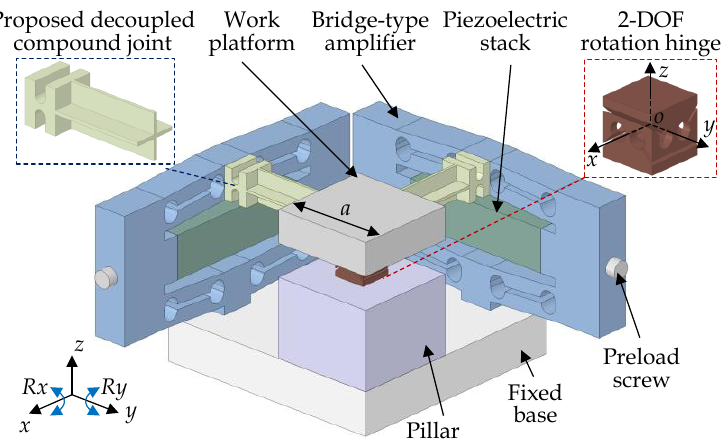
Figure 2. Mechanism of 2-DOF decoupled rotation